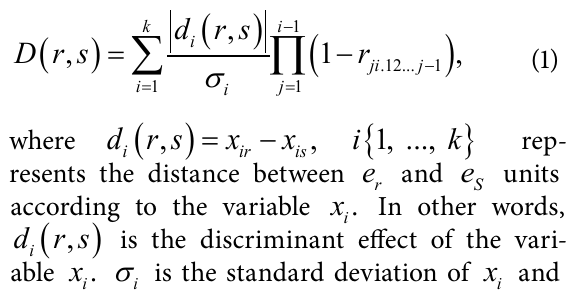
Table 1. Financial ratios used in the study Main groups Ratio Calculation Current ratio Current assets/current liabilities 2 Acid test (liquidity) ratio (Current assets-inventories)/current liabilities 1 Liquidity ratios Cash ratio Activity ratios Financial leverage ratios